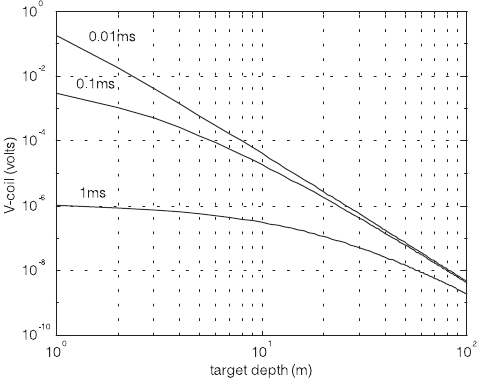
Fig. 7. Maximum voltage response at the receiver in function of target depth, for different time